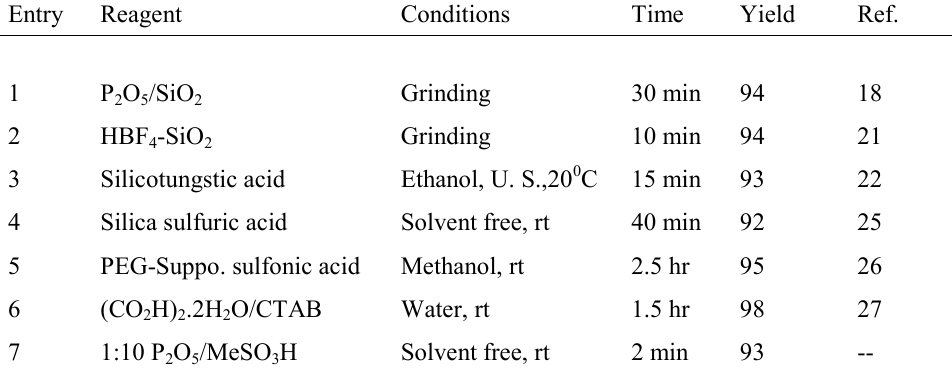
Table 1. Comparison of reaction conditions and the yield of product 3a with reported methods.